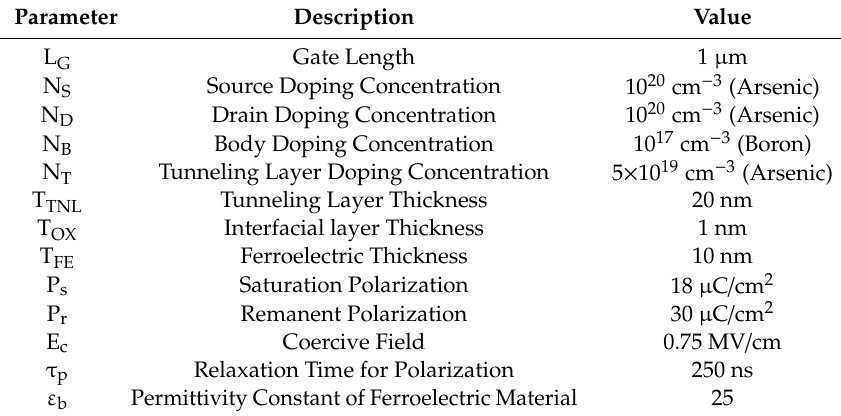
Table 1. Simulation Parameters.